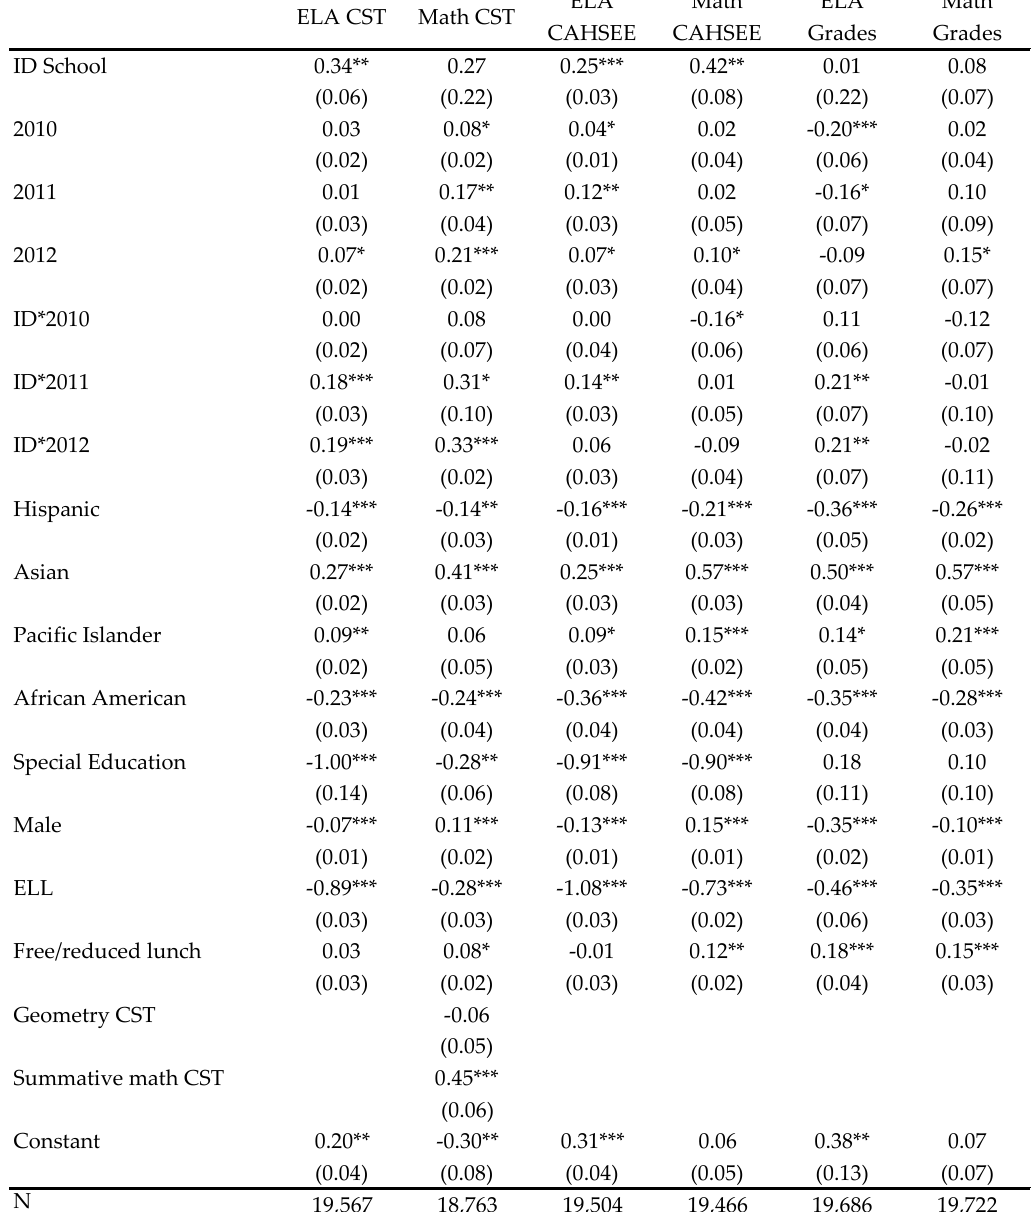
Table S3: Full difference-in-difference estimates of average effects of ID card program